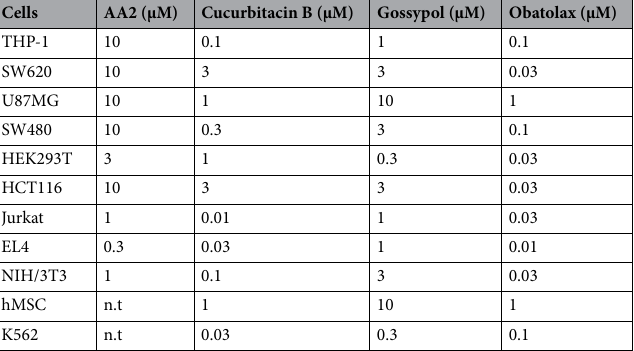
Table 3. Concentrations of AA2, cucurbitacin B, gossypol, or obatoclax in different cells. n.t. Not tested.